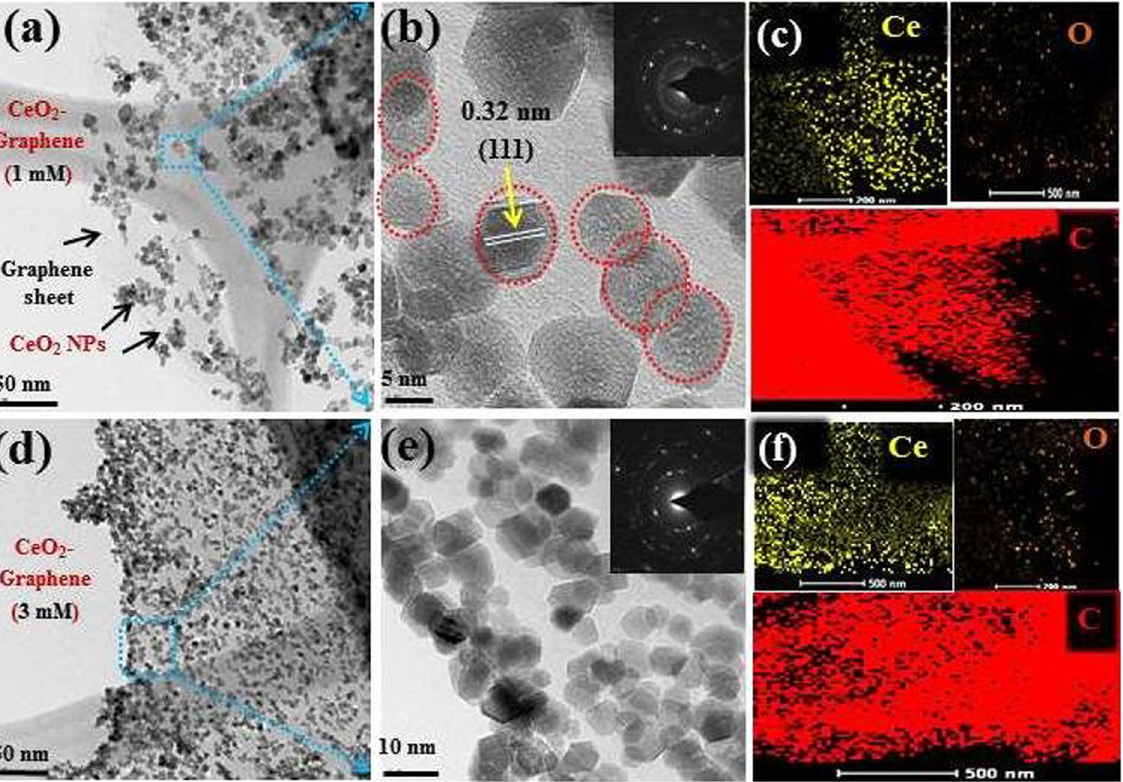
Figure 8. ( a and d ) TEM images of the 1 mM and 3 mM CeO 2 -Graphene nanostructures shows the presence of CeO 2 NPs onto the graphene matrix, ( b and e ) HR-TEM image showing the uniform distribution and lattice fringes of CeO 2 NPs onto the graphene matrix, inset showing the SAED crystal ring pattern ( c and f ), showing elemental mapping of Ce (yellow color), O (orange color), and C from graphene in (red color).